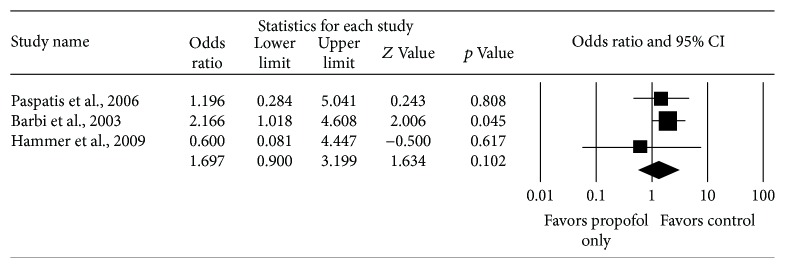
Comparison of cardiac complications in children receiving propofol versus under anesthetic regimens.